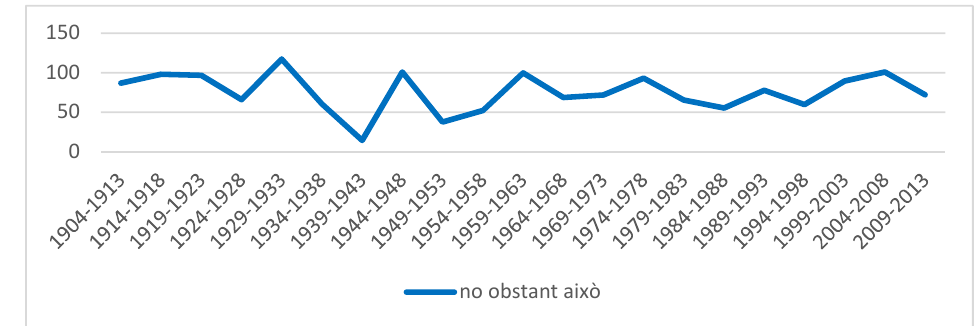
Figure 4. Relative frequency of no obstant això (normalized per 1 million words).